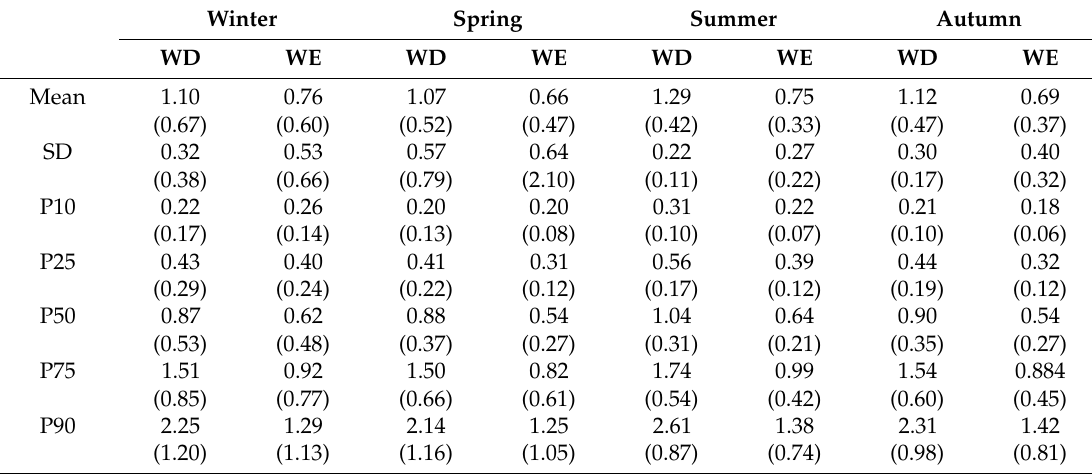
Table 3. Mean, standard deviation (SD) and 10th, 25th, 50th, 75th and 90th percentiles (P10,